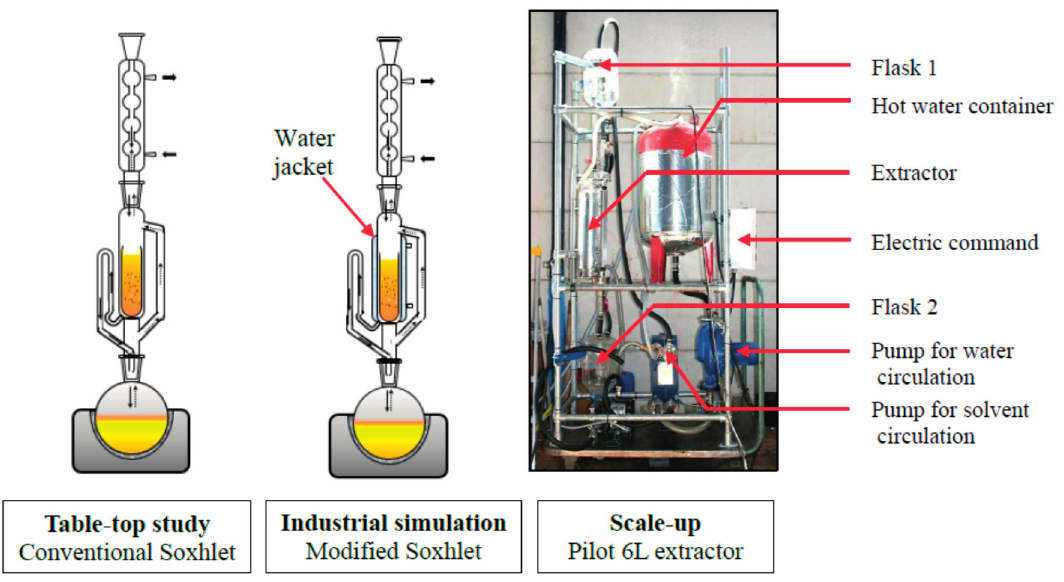
Figure 5. Experimental